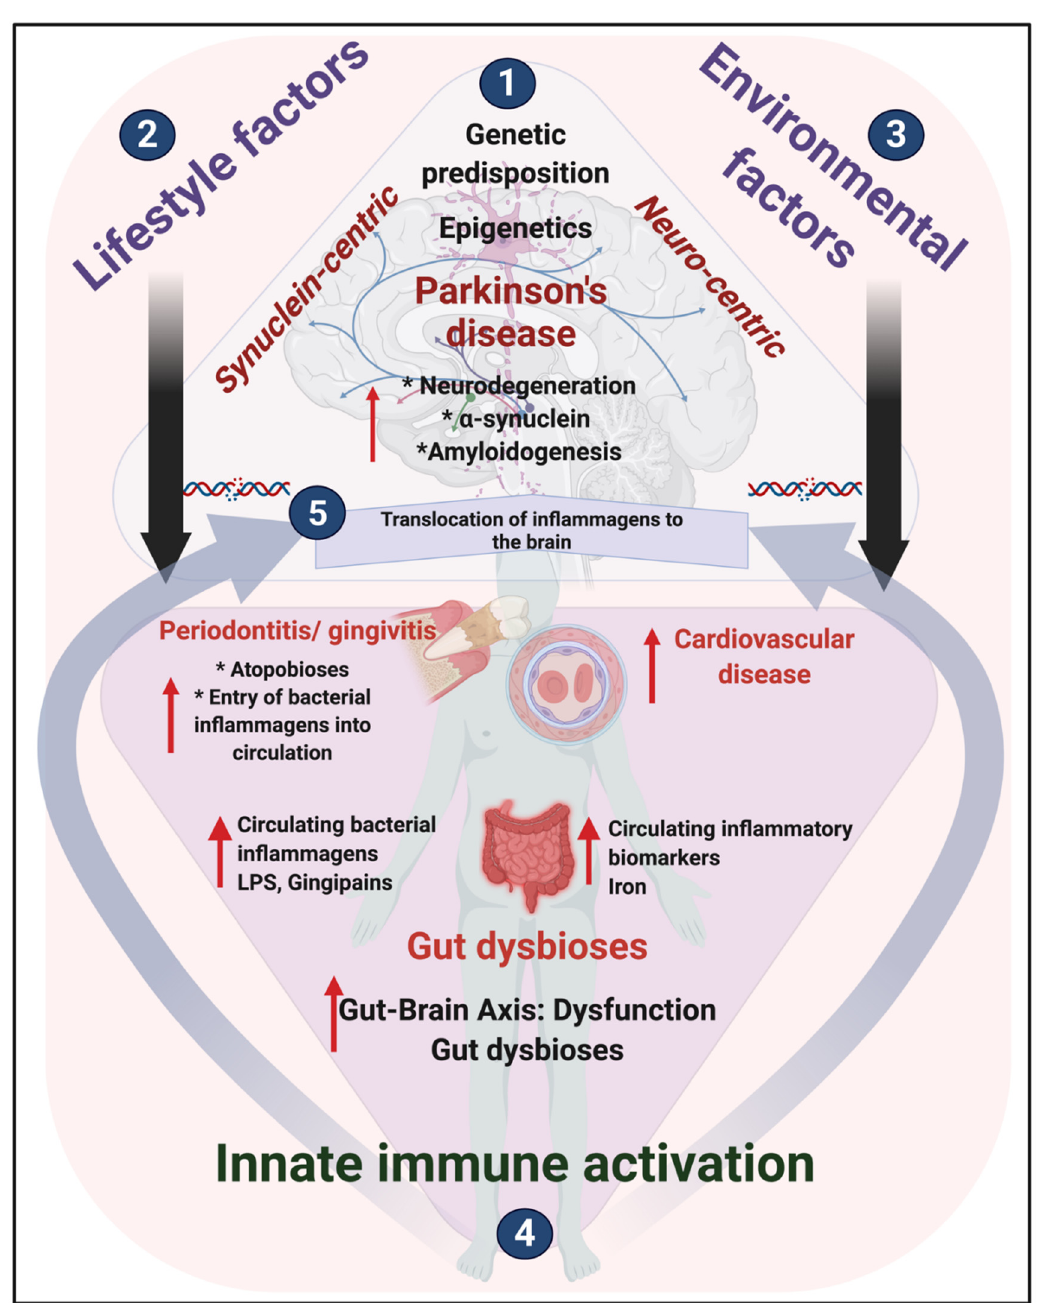
Figure 1. An overview of Parkinson’s disease (PD): what do we know from the literature? (1) Traditional focus on a synuclein-centric and neuro-centric- approach, where researchers predominantly focused for the origins of PD in the central nervous system (CNS). Recently, there has been a shift in focus to look closer at the role of both (2) lifestyle and (3) environmental factors that result in (4) innate immune activation, in the development of PD; these 3 factors (depicted in (2) (3) and (4), directly impact and play a significant role in PD brain neurodegeneration. (5) Inflammagens and inflammatory cytokines from the periphery can translocate to the brain.